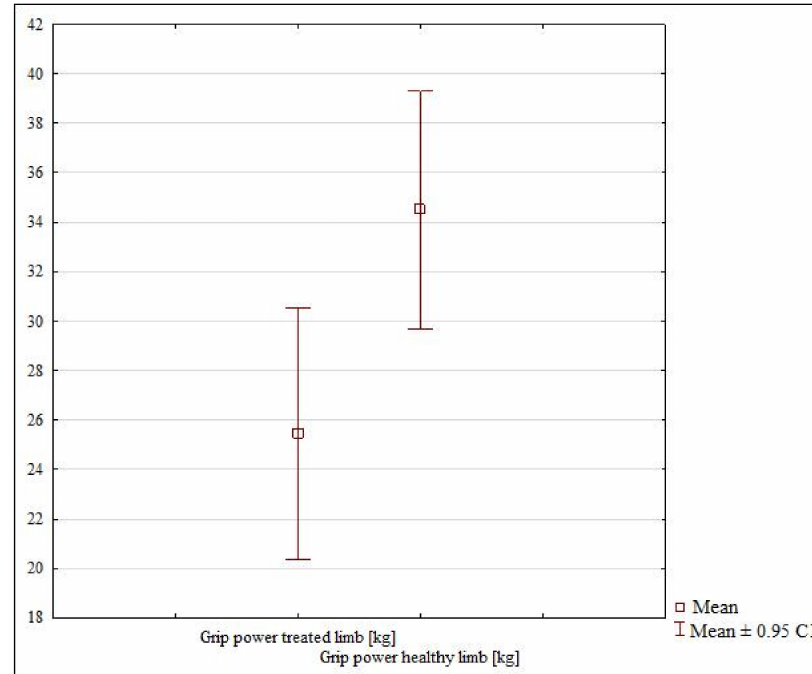
Figure 2. The grip strength in the healthy and treated limb in the 4-week